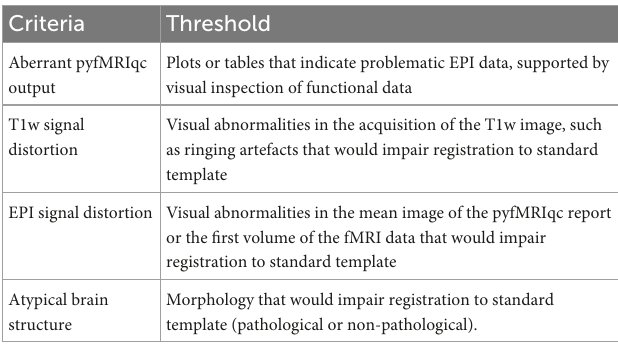
TABLE 3 Qualitative criteria for determining dataset inclusion.